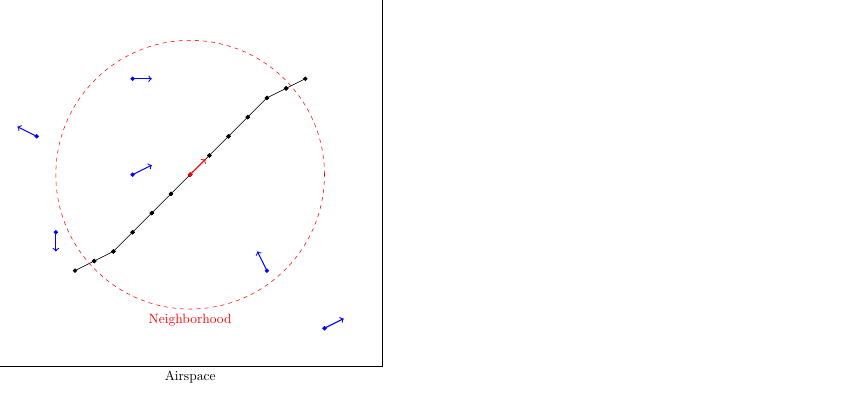
Figure 1. Spatial neighborhood of a 4D point in a curvilinear trajectory sampled in